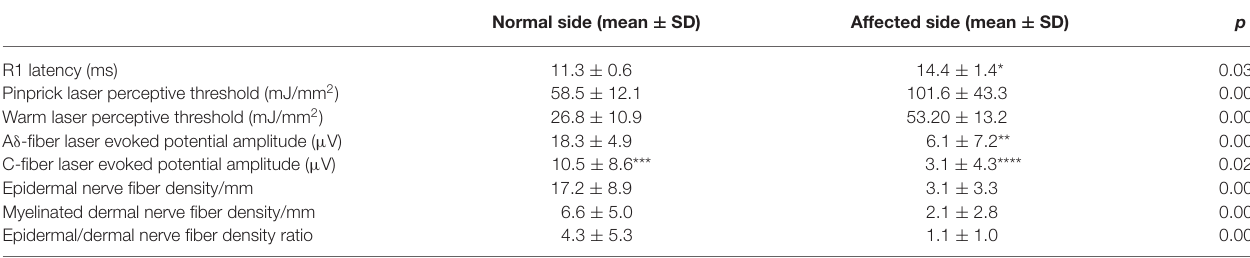
TABLE 2 | Abbreviation, source and dilution of immunohistochemical markers.